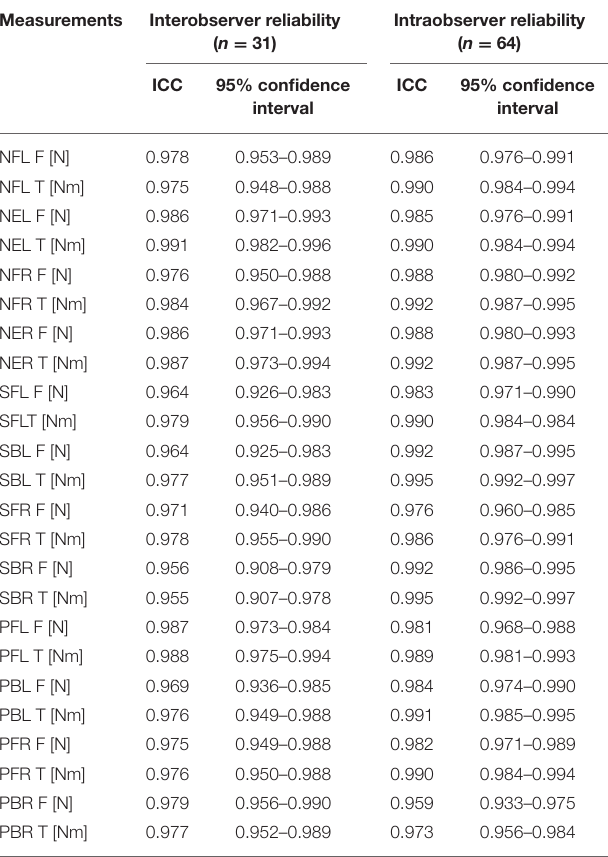
TABLE 1 | Interobserver and intraobserver reliability of the force F (N) and torque T (Nm) measurements.